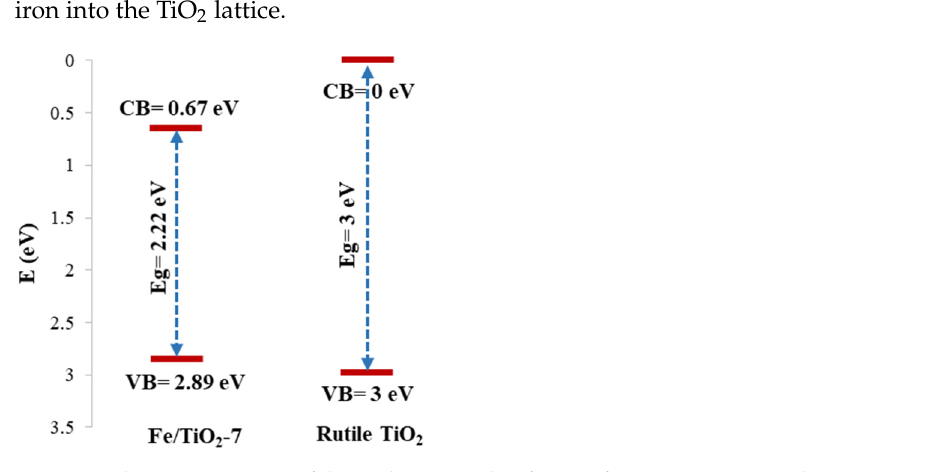
Figure 8. Electronic structure of the rutile TiO 2 and Fe/TiO 2 -7 from UV-Vis DRS and XPS measurements.